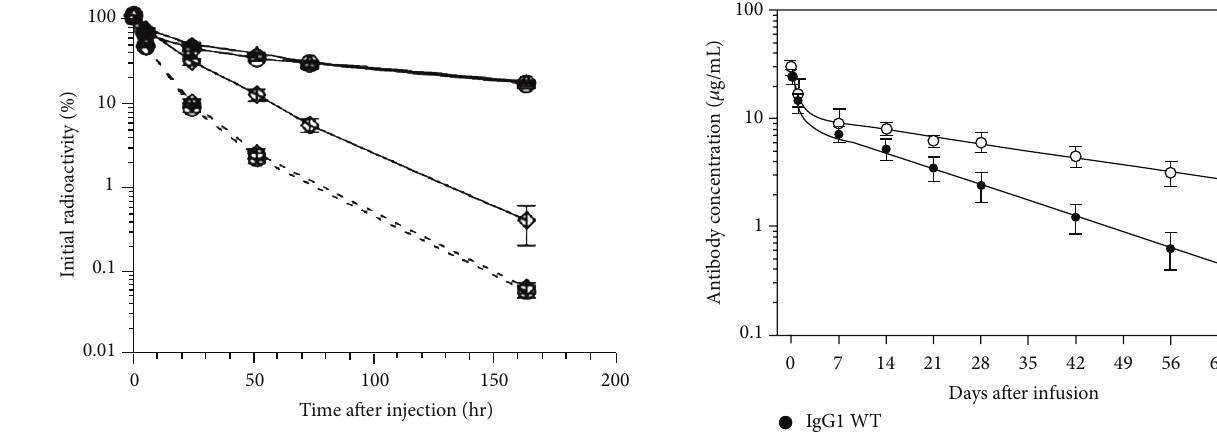
Figure 4: Clearance of intravenously injected 125 I-labelled mouse IgG1 and chicken IgY antibodies in mice with and without 𝛽 2- microglobulin. Mouse IgG1, solid line; chicken IgY, broken line; 𝛽 2-microglobulin +/+, circles; 𝛽 2-microglobulin +/ − , triangles; 𝛽 2- microglobulin +/ − , diamonds; 𝑛 = 5 for each group (adapted from Figure 1, [90]).